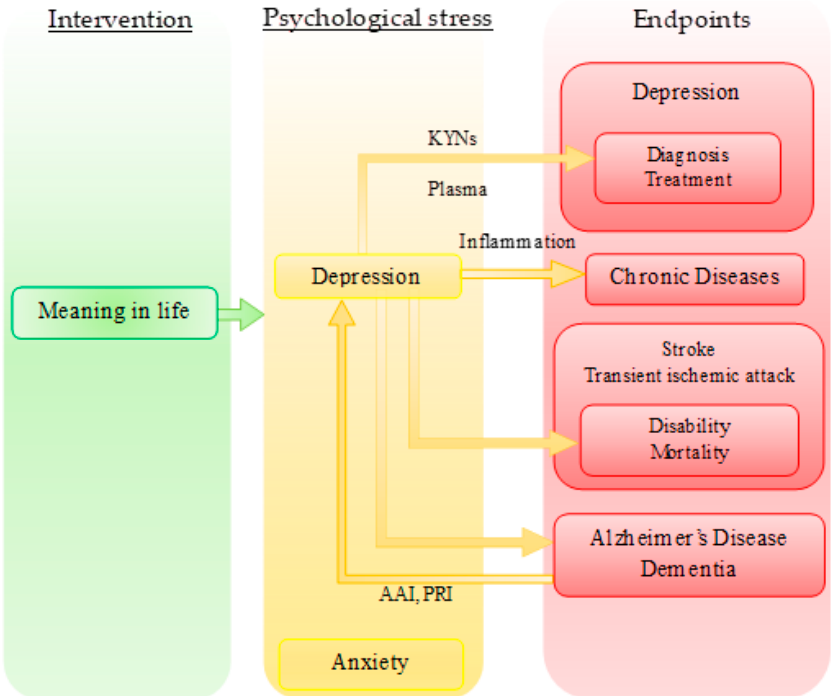
Figure 5. Meaning-centered psychotherapy, its effective targets, and endpoints. Meaning in life is a predictor of psychological stress. Psychological stress causes depression, anxiety, and cognitive impairment. Depression is a measurable indicator which predicts diagnosis and/or treatment of depression with kynurenines (KYNs), chronic diseases with inflammation, disability and mortality of stroke and transient ischemic attack, and Alzheimer’s disease and dementia. Depression of Alzheimer’s diseases and dementia can be ameliorated by AAI (animal-assisted intervention) and pet-robot intervention